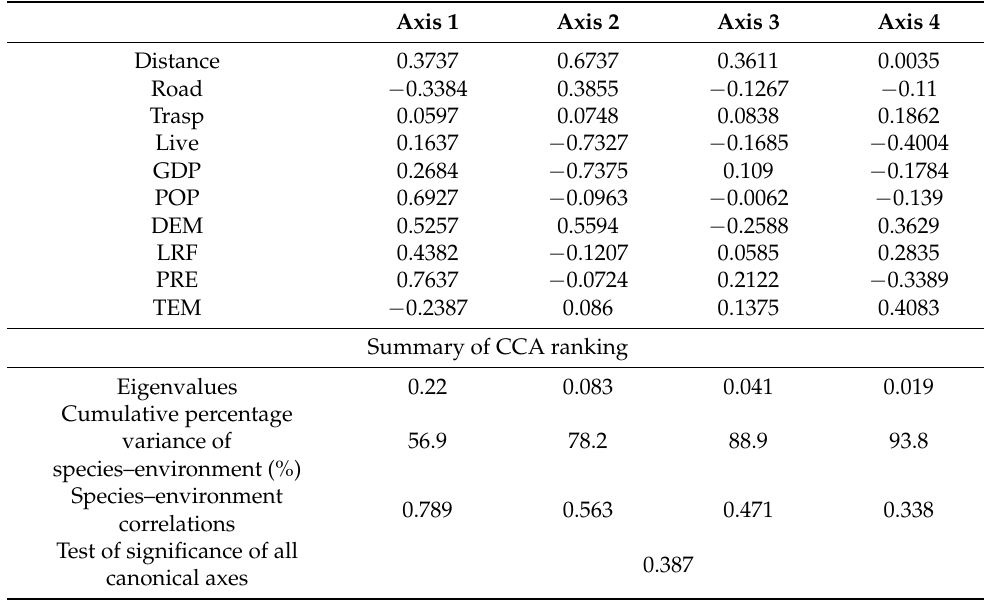
Table 5. Correlation coefficients between environmental factors and CCA ordination axes and